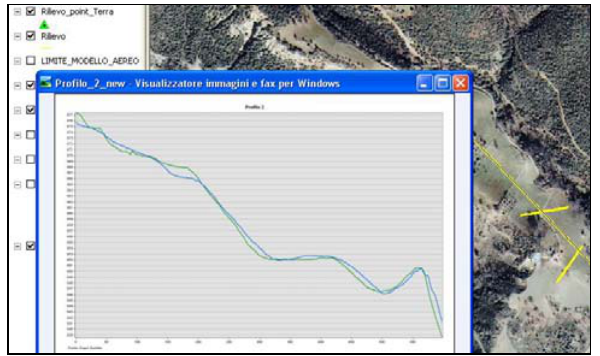
Figure 6. Comparison between profiles (test 1)